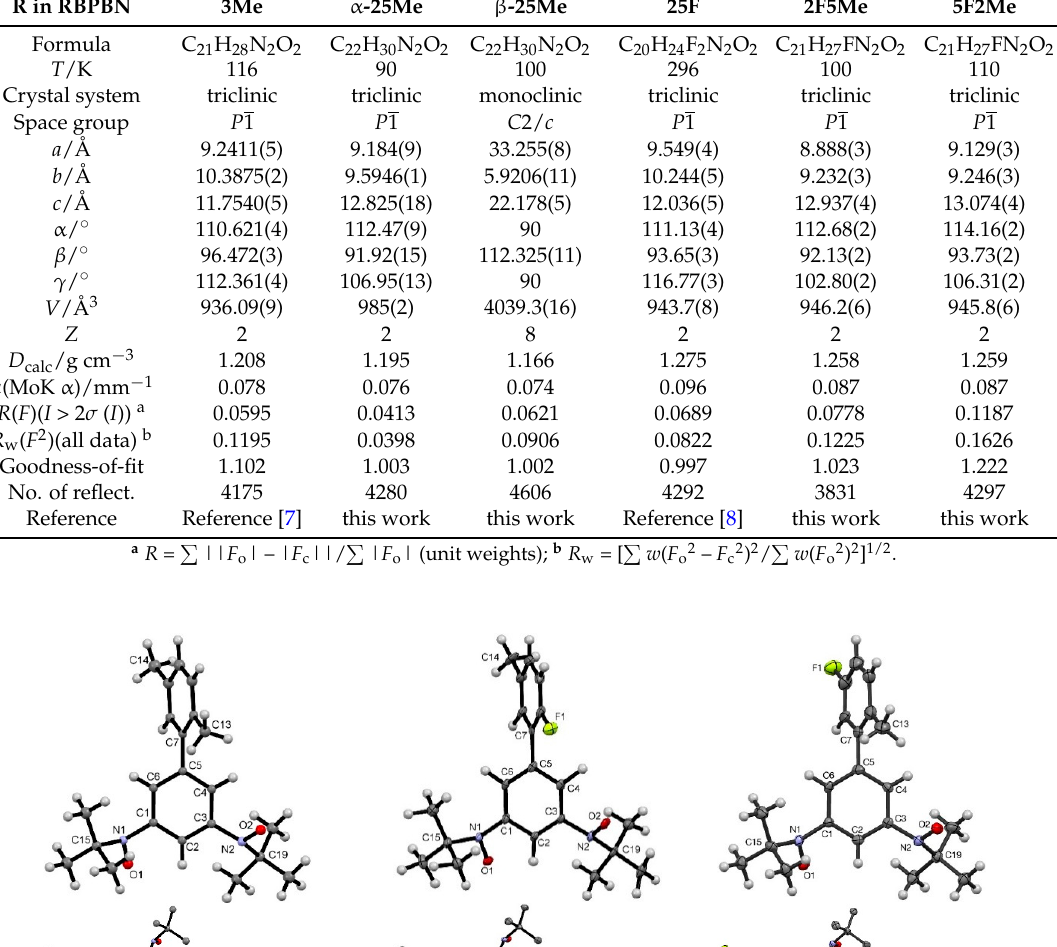
Table 1. Selected crystallographic data for BPBN derivatives.